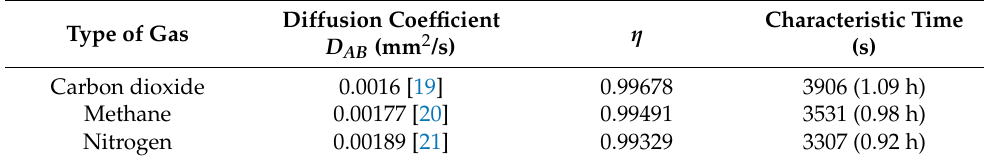
Characteristic Time η (s)